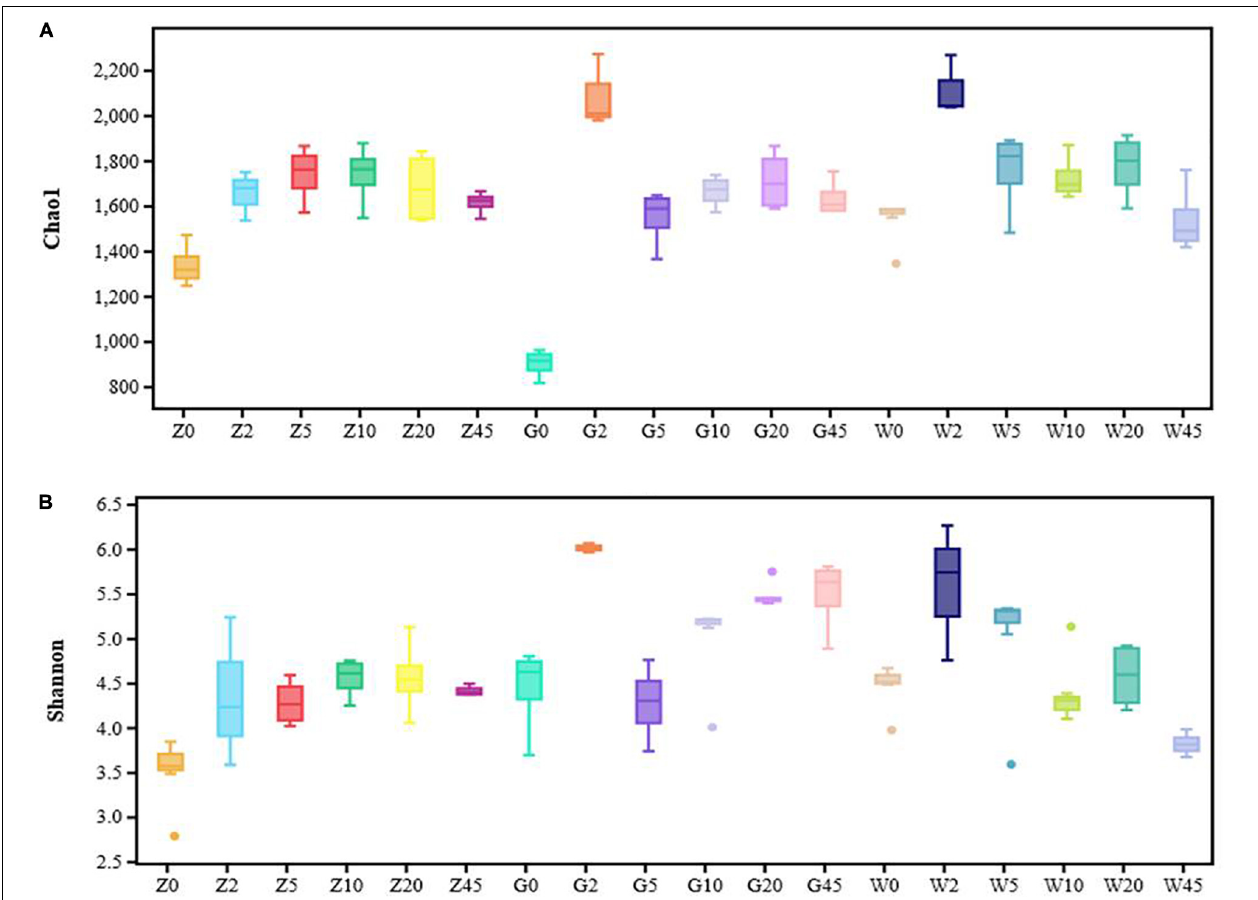
FIGURE 2 | Community diversity and richness of the silages for every period in the area of Ziyun, Guanling, and Weining: (A) Chaol index of silage samples for every period (0, 2, 5, l0, 20, and 45 days); (B) Shannon index of silage samples for every period (0, 2, 5, l0, 20, and 45 days). Solid discrete points means